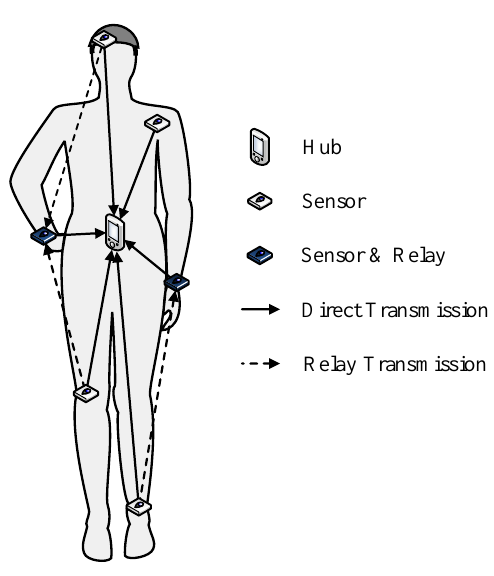
Figure 1. Deployment of wireless nodes.